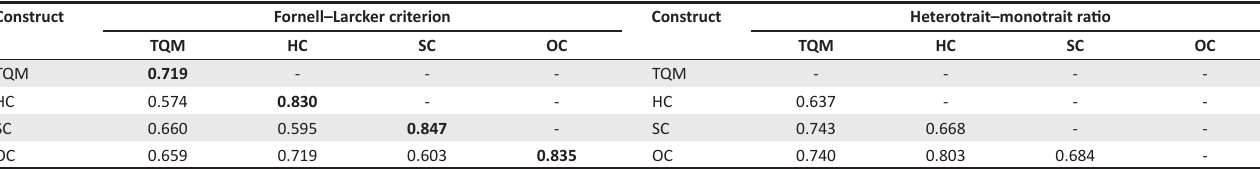
TABLE 2: Discriminant